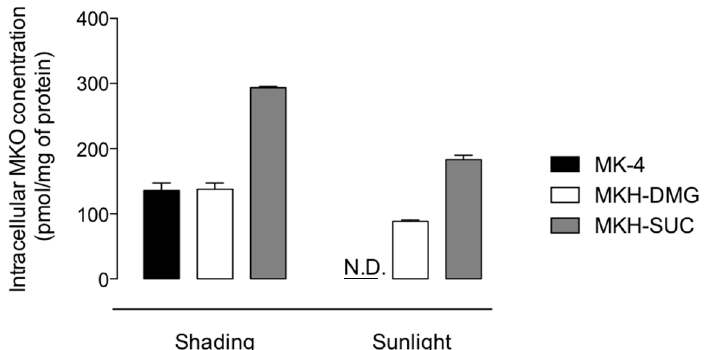
Figure 8. MKO levels in HaCaT cells after 48 h of treatment with previously sunlight-irradiated MK-4 or MKH derivatives. Shading sample cells were treated with each compound with no sunlight exposure. Sunlight sample cells were treated with each compound irradiated with sunlight (12,000 lx) for 3 h. Data represent mean ± SD ( n = 3).